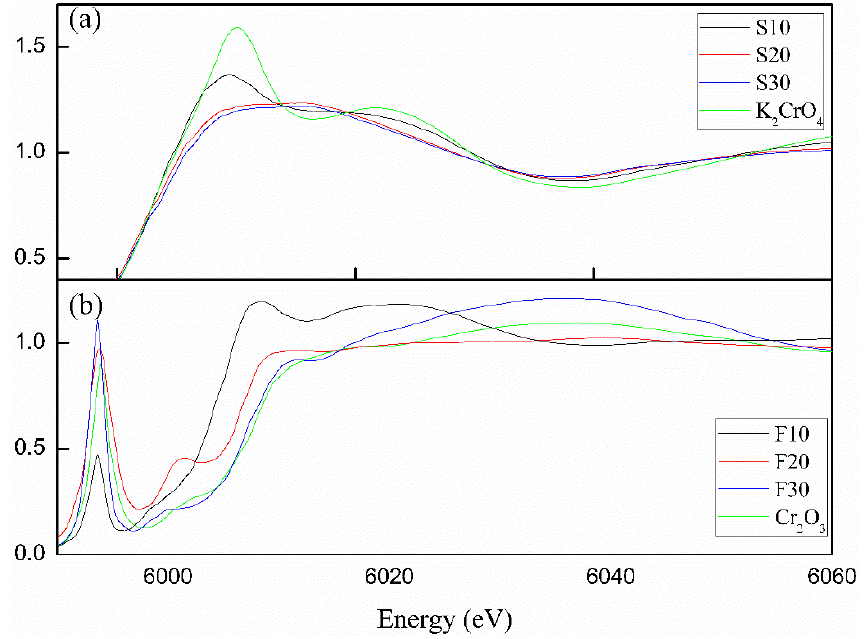
Figure 9. XANES patterns of Cr in different samples ( a ) S10, S20, S30; ( b ) F10, F20, F30.